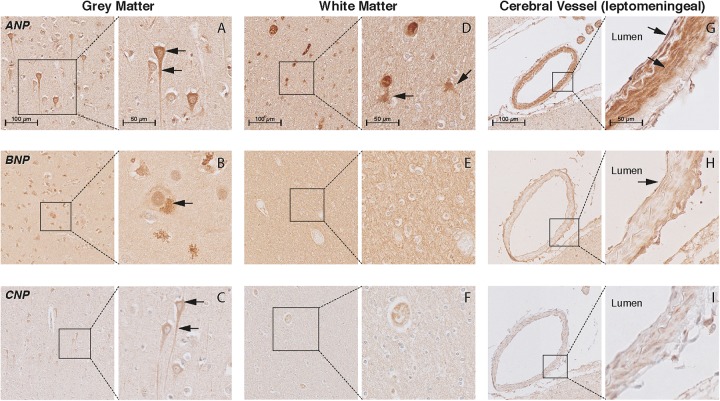
Localization of ANP, BNP, and CNP in the frontal cortex of non-demented controls. NP immunohistochemistry in the frontal lobe (middle frontal gyrus) of non-demented controls. (A–C) ANP, BNP, and CNP-positive neurons. Arrows point to the cytoplasm (ANP and CNP), neuronal processes (ANP and CNP), and Nissl bodies (BNP); (D) ANP-positive astrocyte-like cells in the white matter; (E,F) negative BNP and CNP staining in the white matter; (G) ANP-positive endothelium and smooth muscles; (H) BNP-positive endothelium, and (I) negative CNP staining in the leptomeningeal vessels.